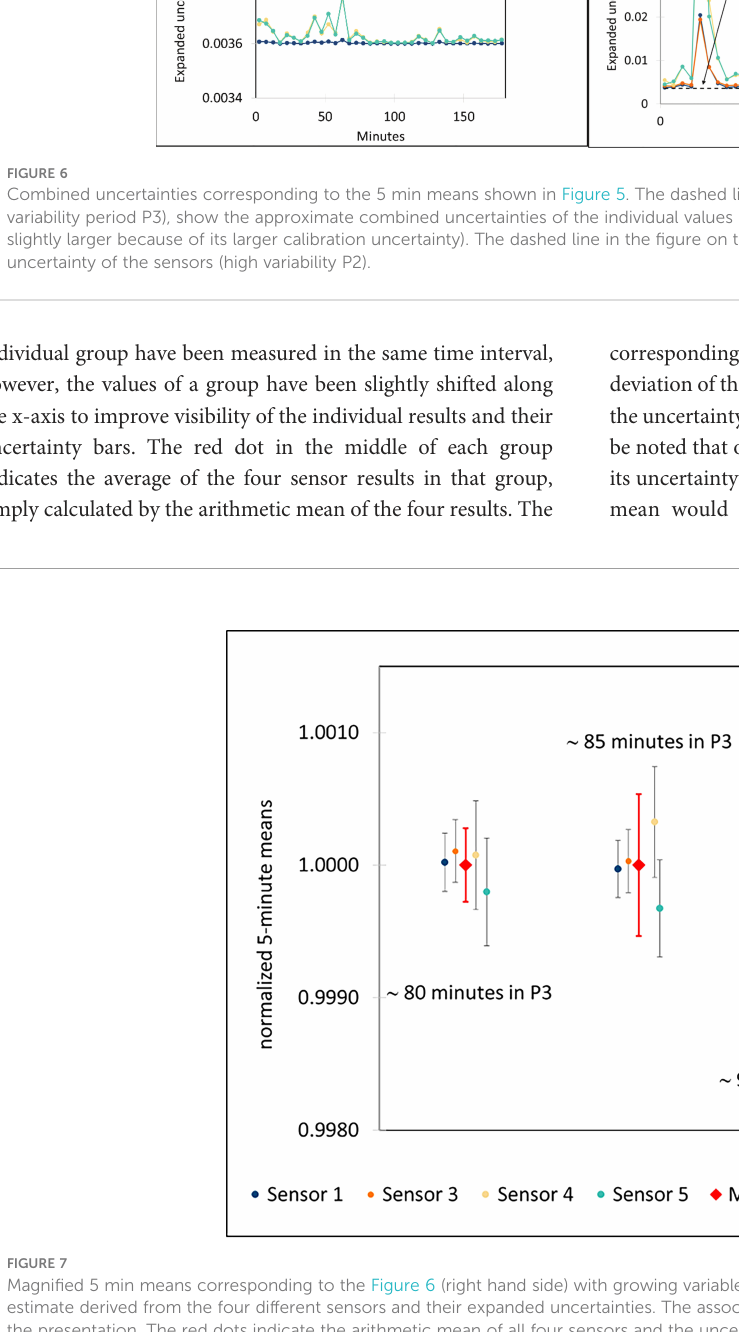
FIGURE 7 Magni fi ed 5 min means corresponding to the Figure 6 (right hand side) with growing variable conditions, illustrating the spread of the best estimate derived from the four different sensors and their expanded uncertainties. The associated times have been slightly shifted to improve the presentation. The red dots indicate the arithmetic mean of all four sensors and the uncertainty bars their expanded